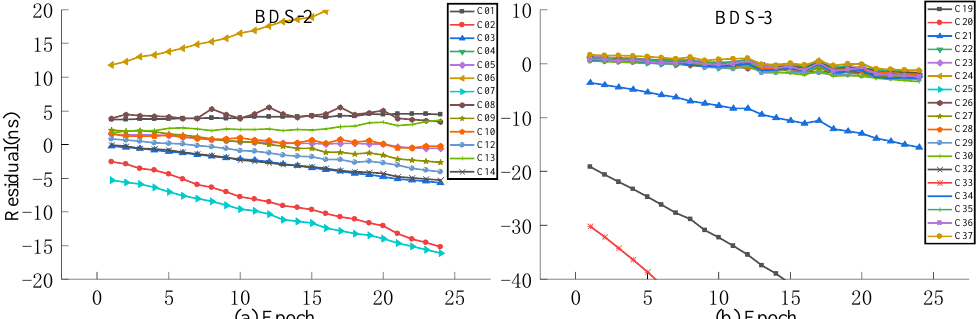
Figure 14. The residual plot of the QP model using the 6th hour update ultra-fast clock product of the day. ( a ) The residual value of BDS-2 predicted after 6 h. ( b ) The residual value of BDS-3 predicted after 6 h.